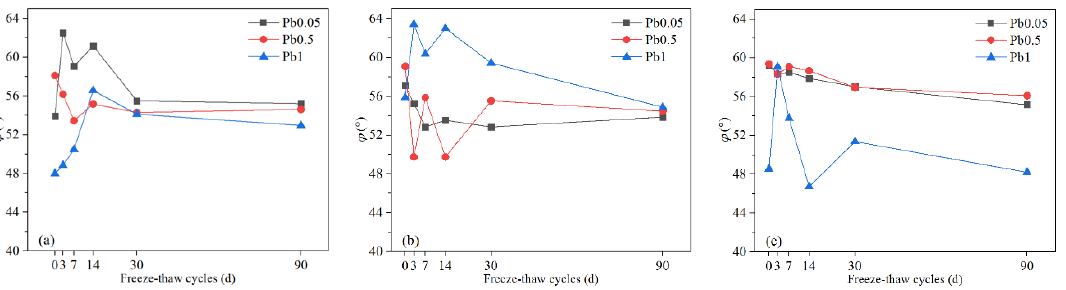
Figure 8. The ϕ values of Pb-CSCSs with the same compound binder and di ff erent contaminant Figure 8. The φ values of Pb-CSCSs with the same compound binder and different contaminant